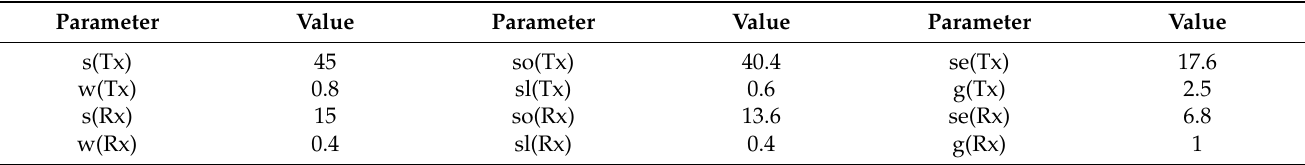
Table 1. The parameters of the Tx and Rx